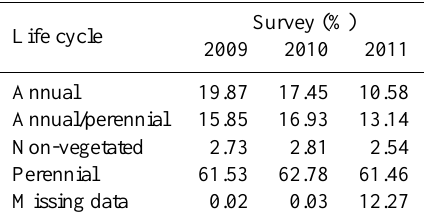
Table 4. Changes of the FAO-LCCS category life cycle. Note that the survey data of 2011 are incomplete.